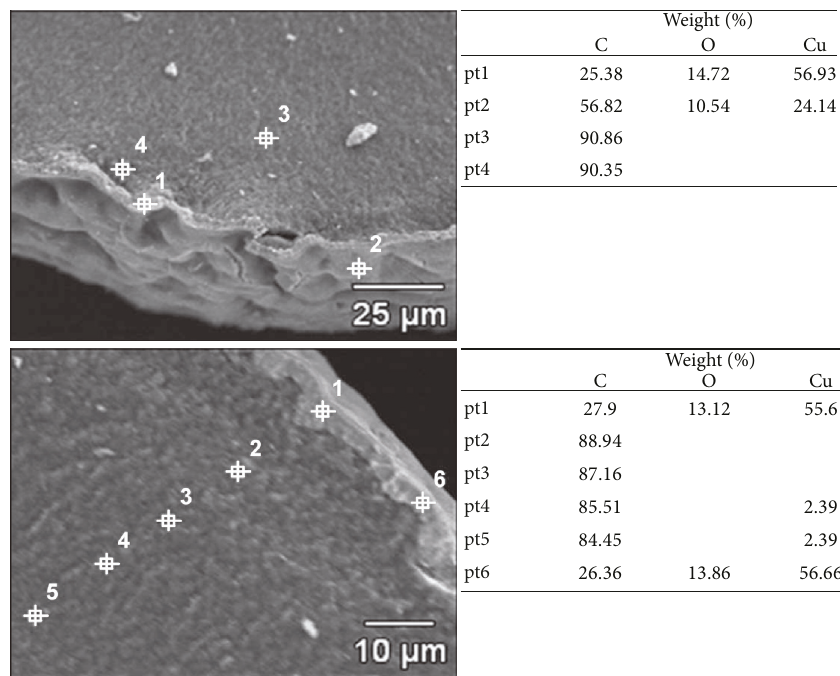
Figure 3: SEM image with EDS analysis of the cross section of the polymer bead impregnated with CuO.